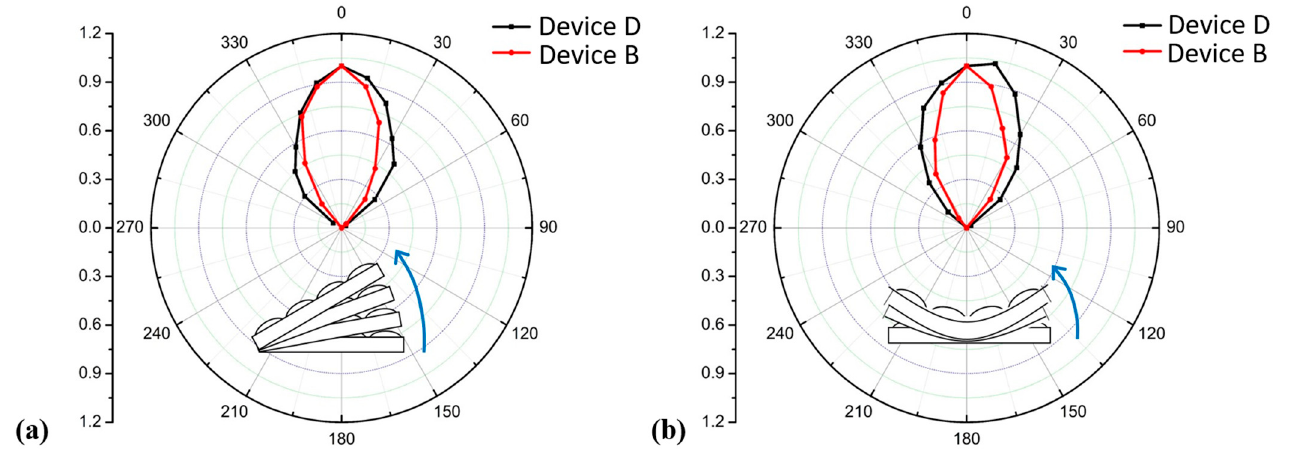
Figure 4. Device efficiency of Devices B and D under different ( a ) illumination angles and ( b ) bend- ing angles.